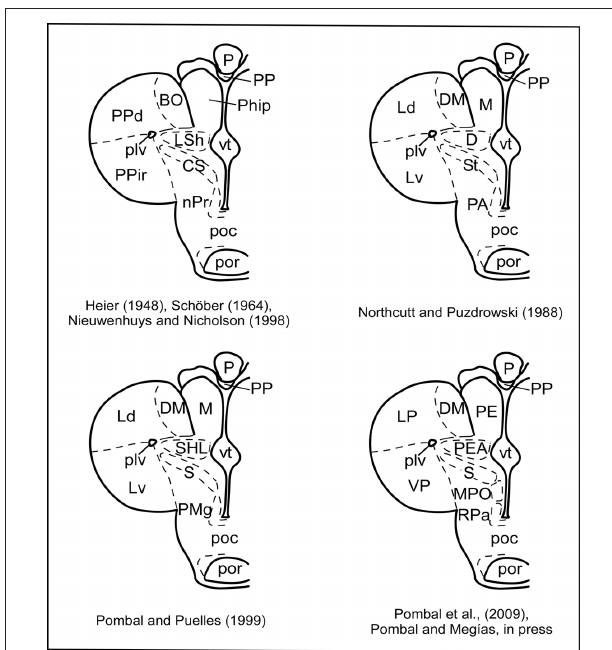
Figure 6 | Schematic drawings of a transverse section through the adult lamprey telencephalon and rostral hypothalamus showing the evolution of the nomenclature of the different nuclei and areas. BO, bulbus olfactorius; CS, corpus striatum; D, dorsal pallium; DM, dorsomedial telencephalic neuropile; Ld, lateral pallium, dorsal part; LP, lateral pallium; LSh; lobulus subhippocampalis; M, medial pallium; Lv, lateral pallium, ventral part; MPO, medial preoptic nucleus; nPr, nucleus preopticus; P, pineal organ; PA, preoptic area; PE, prethalamic eminence; PEA, pallial extended amygdala; Phip, primordium hippocampi; plv, posterior lateral ventricle; PMg, magnocellular preoptic nucleus; poc, postoptic commissure; por, postoptic recess; PP, parapineal; PPd, primordium pallium dorsalis; PPir, primordium piriforme; RPa, rostral paraventricular area; S, striatum; SHL, subhippocampal lobe; St, striatum; VP, ventral pallium; vt, impar